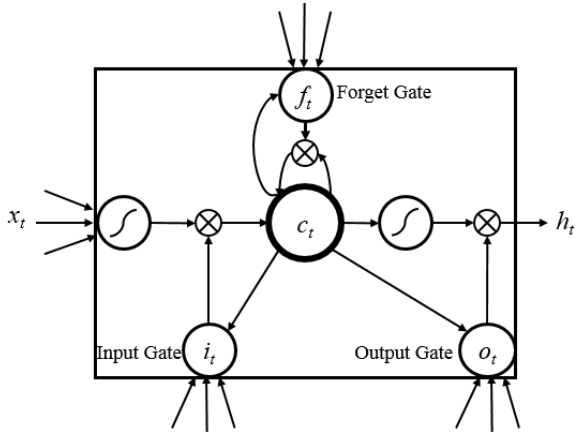
Figure 7. A visual diagram of the LSTM architecture, showing the input, forget and output gates, as well as the cell state computation and